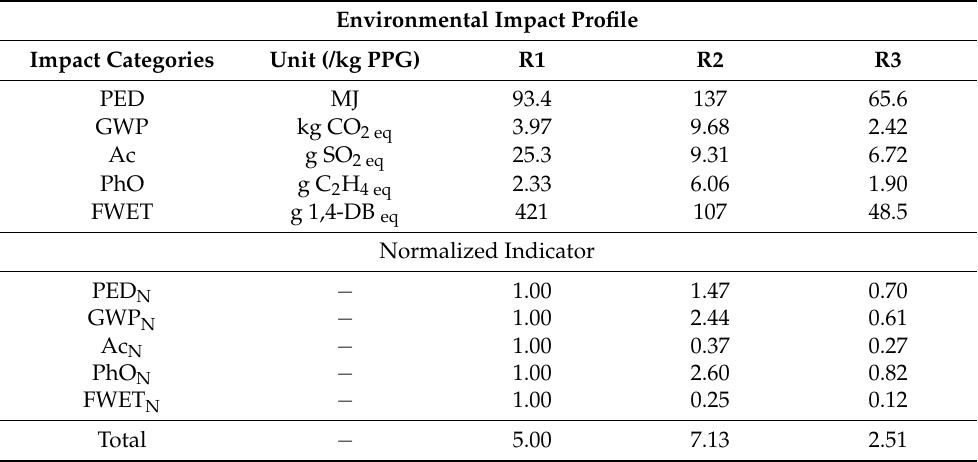
Table 5. Development of single performance indicators for PPG production routes